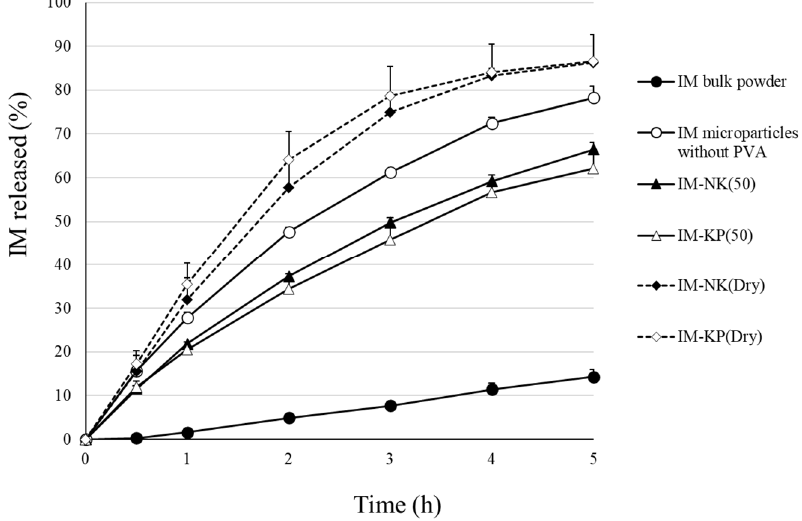
Figure 8. Drug Release Profiles from the IM Microparticles. Each Point Represents the Mean ± SD ( n = 3).